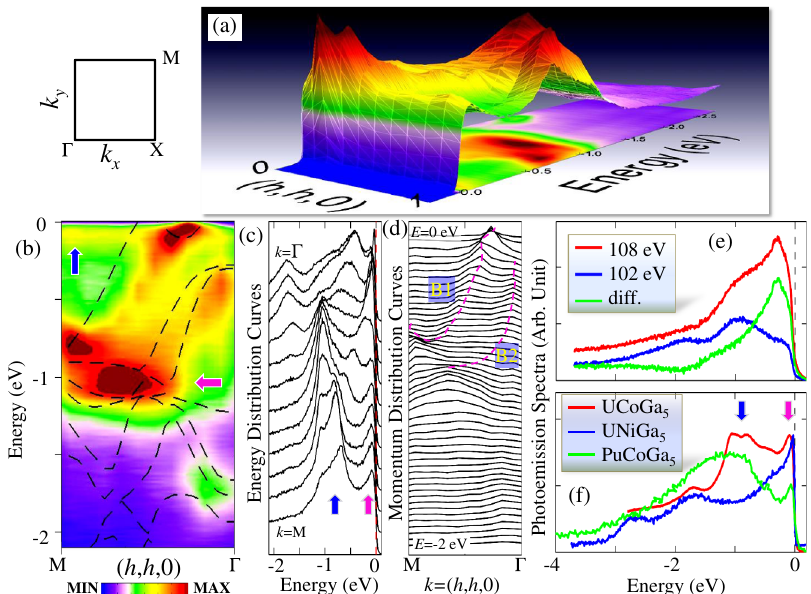
FIG. 1. Dispersion and measured ARPES spectral-function anomaly. (a) 3D intensity map of UCoGa 5 along the M ! (cid:1) direction ð h; h; 0 Þ in the Brillouin zone. (b) Same data plotted as the 2D contour map and compared to the corresponding ab-initio GGA electronic band-structure dispersions (black dashed lines). Arrows indicate two quasi-non-dispersive energy scales of higher intensities. All the ARPES data are collected at the photon energy of 46 eV, with energy resolution better than 20 meV. (c) The EDCs are plotted for fixed momenta. The curves from bottom to top are chosen for equally spaced momentum points from M to (cid:1) . The arrows have the same meaning as in panel (b). (d) MDCs for fixed binding energy. The bottom to top curves are chosen from E ¼ (cid:1) 2 : 1 to E ¼ 0 eV . The dashed lines are guide to the eyes for two extracted low-lying dispersions of anomalous character, analyzed in Fig. 2. (e) PES of UCoGa 5 at photon energies h(cid:1) ¼ 108 eV (red line) and h(cid:1) ¼ 102 eV (blue line). Their difference curve (green line) reveals the dominant 5 f character [26]. (f) Partial PES of UCoGa 5 (momentum integrated between (cid:1) and M) compared with two related actinides. UNiGa 5 and PuCoGa 5 exhibit antiferromagnetic [13] and superconducting [29] ground states, respectively. All data are normalized arbitrarily for ease of